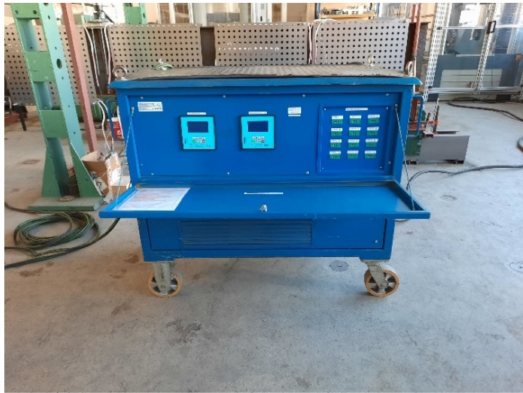
Figure 3. Heat treatment unit W6512.